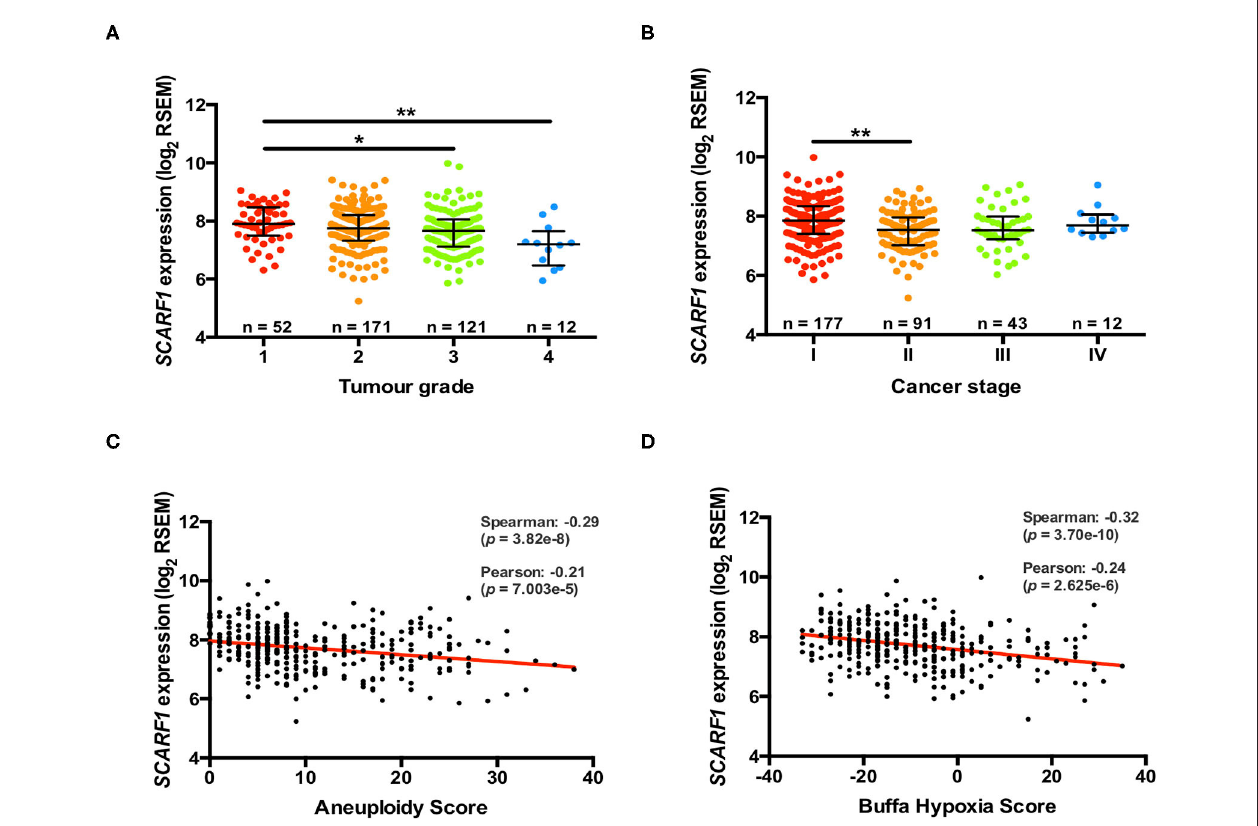
FIGURE 2 | More advanced and aggressive tumors exhibit lower SCARF1 expression. (A) SCARF1 expression in HCC tumor tissues of different histological grade. * and ** are representative of statistical significance as measured by the Kruskal–Wallis test, where p ≤ 0.05 and p ≤ 0.01, respectively. (B) SCARF1 expression in HCC tumor tissues from the four cancer stages. **indicates statistical significance as measured by the Kruskal–Wallis test, where p ≤ 0.01. SCARF1 expression correlated to tumor aggression parameters (C) . Aneuploidy score ( n = 355) and (D) Buffa Hypoxia score ( n = 361). Data in this Figure was generated from the TGCA dataset using the cBioPortal website (https://www.cbioportal.org/) (accessed 25th Feb